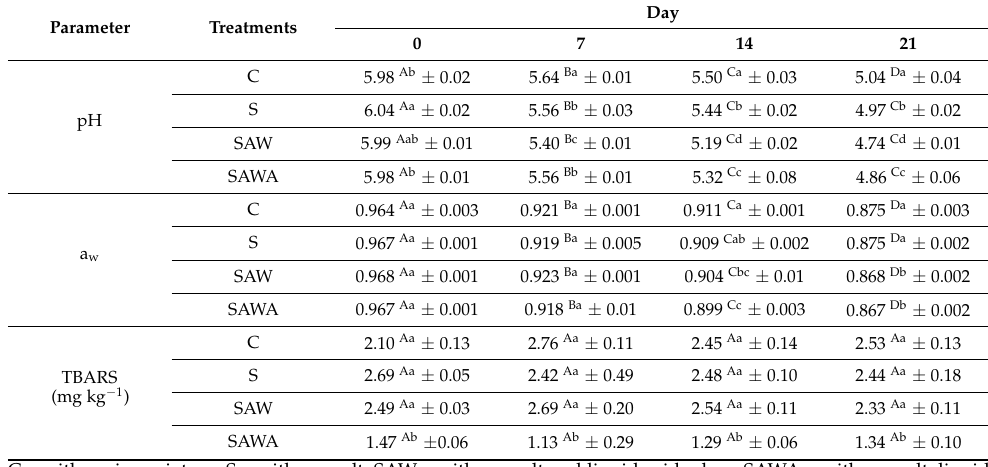
Table 2. pH, water activity and TBARS of dry fermented sausages during processing (mean ± SD). Parameter